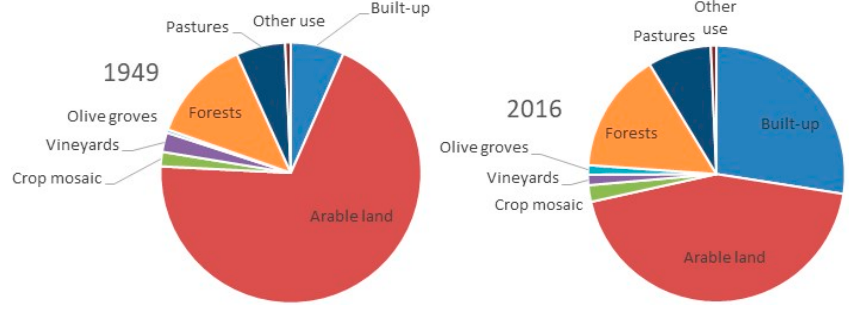
Figure 4. Landscape composition (%) by year considering eight land-use classes. Based on MSPA, trends over time in the per cent ‘core’ area were illustrated in Table 2. Built-up areas contained a relatively stable proportion of ‘core’ patches with a moderate increase from 34.9% in 1949 to 35.7% in 2016. Arable land, vineyards, pastures and crop mosaics experienced the most intense decline over time. The other classes had a less intense decline in ‘core’ parches; forests were the class with the lowest negative rate of change in ‘core’ patches. Table 2. ‘Core’ area (%) and annual changes (%) by year and land-use class (difference was calculated as annual per cent change over time).